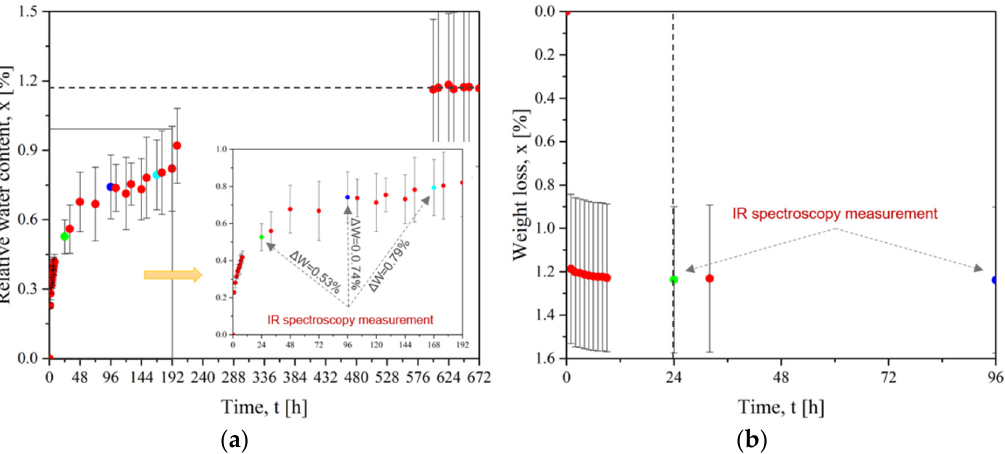
Figure 6. For HM63/PEEK ( a ) Evolution of water diffusion with time at 25 °C and ( b ) Evolution of mass loss with drying time at 150 °C (dots of different colors represent measurement by FTIR spec- troscopy).